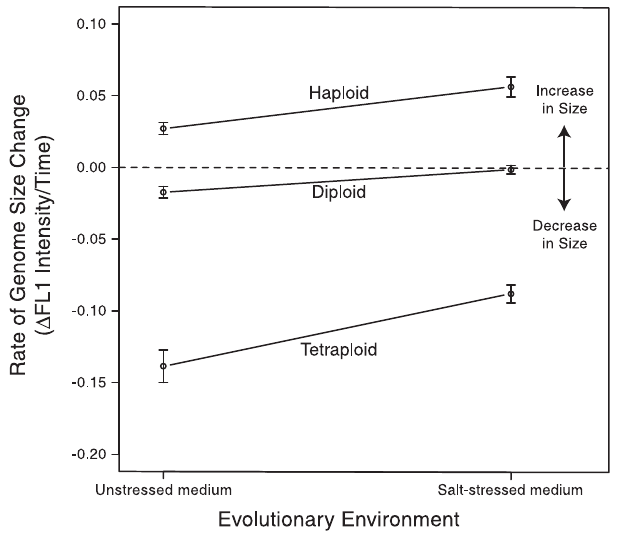
Figure 3. Rate of Genomic Size Change by Ploidy and Environment Rate of change was calculated by fitting linear regression lines through timeseries data (Figure 1) for each individually evolved line. Each data point thus represents the mean 6 SE of five slope measures. This figure shows that haploids increased in genome size faster in salt, while tetraploids decreased in genome size more slowly in salt. DOI: